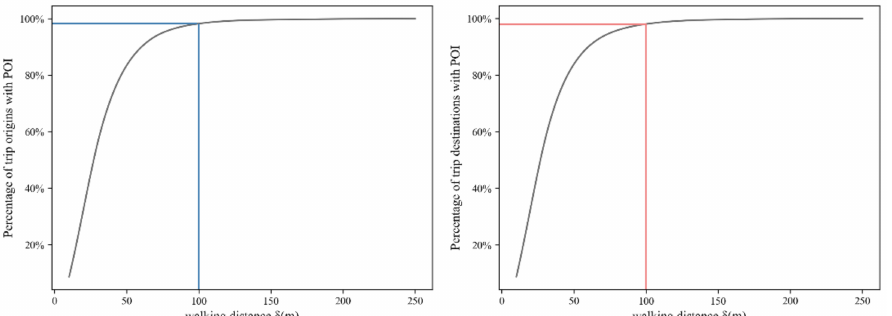
Figure 4. Percentage of origins and destinations that contain at least one POI within different walking